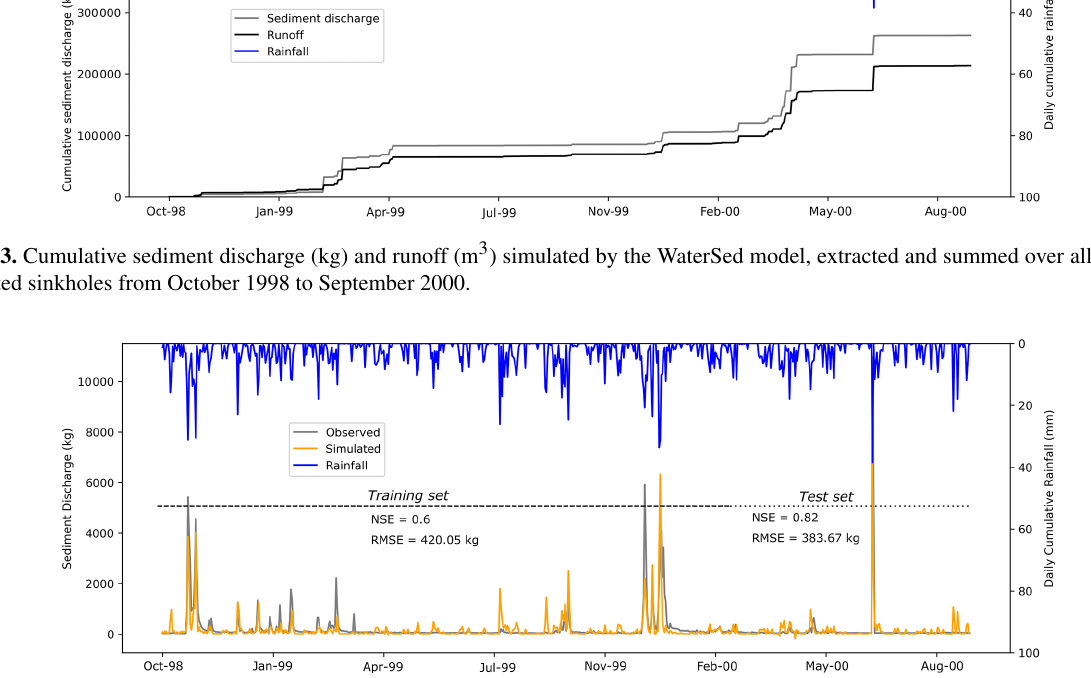
Figure 4. Observed and simulated sediment discharge (kg) at the water treatment plant using the DNN